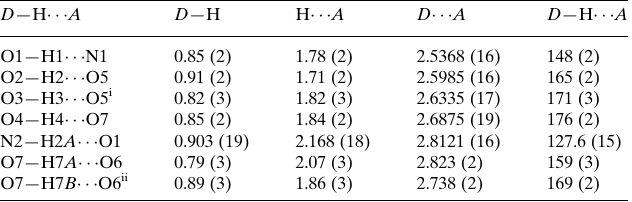
Hydrogen-bond geometry (A˚ , (cid:4)